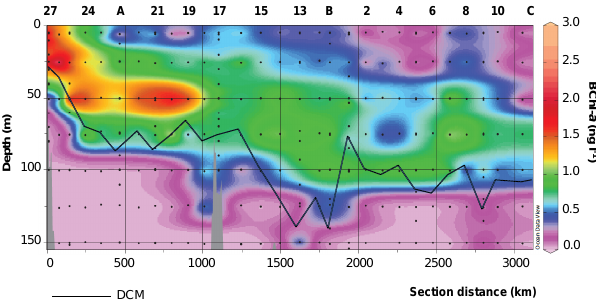
Fig. 2. Longitudinal cross section of BChl- a concentration along the BOUM transect, from the most north-western station (left) to the most eastern station (right) and for the 0–150m layer. Depth of the deep chlorophyll maximum (DCM) is also indicated (black